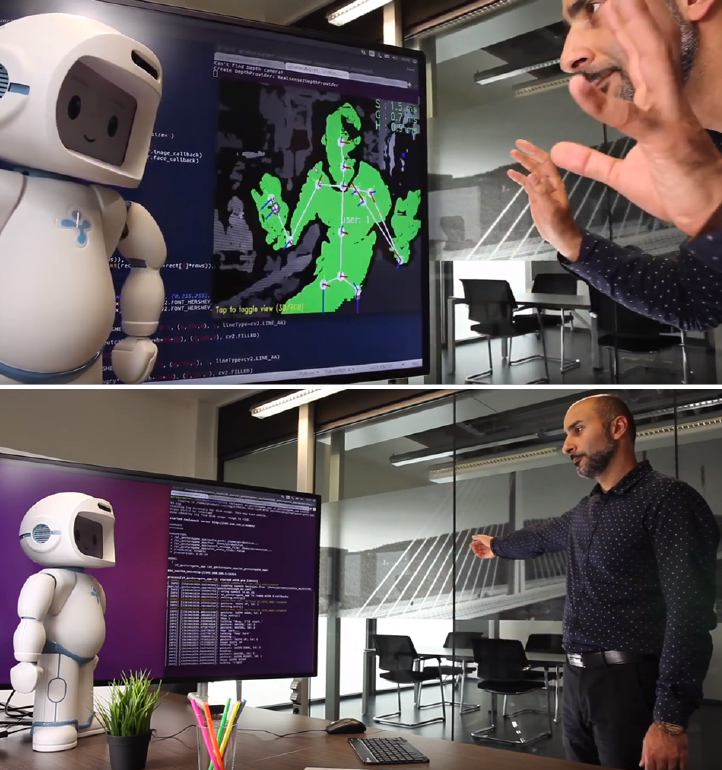
Figure 5. QTrobot collecting facial emotions and body postures of user during interaction.